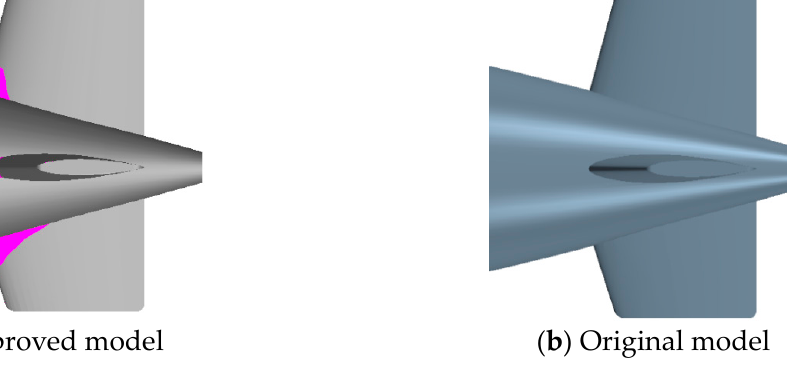
The tail rudder model.